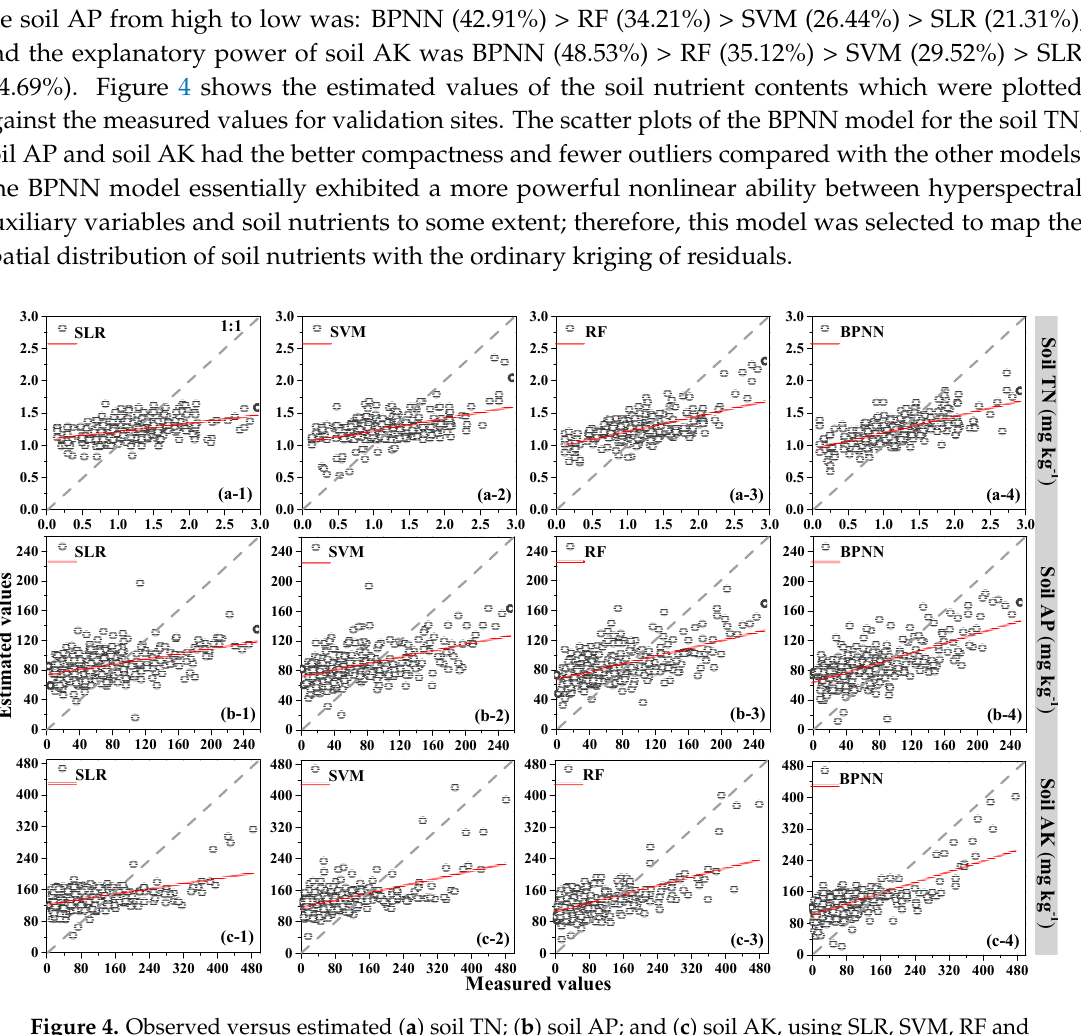
Figure 4. Observed versus estimated ( a ) soil TN; ( b ) soil AP; and ( c ) soil AK, using SLR, SVM, RF and BPNN models at the validation set.